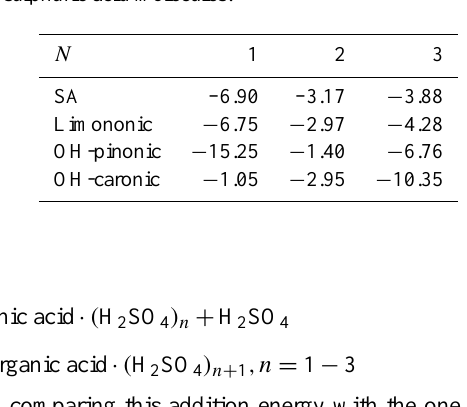
Table 5. Free energy (kcalmol − 1 ) for the addition of one sulphuric acid molecule onto a cluster containing one organic acid molecule and n sulphuric acid molecules.